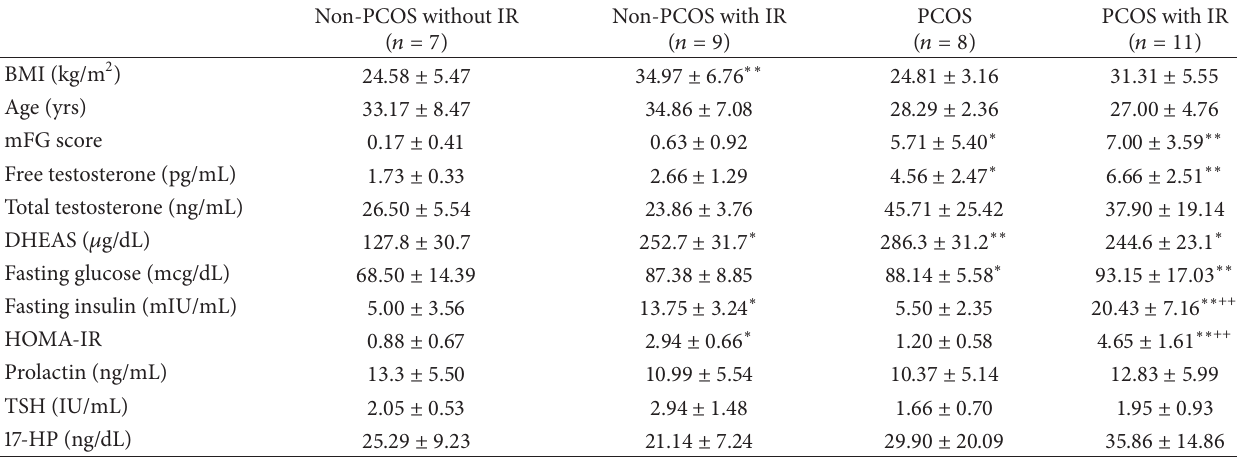
Table 1: Clinical characteristics of study